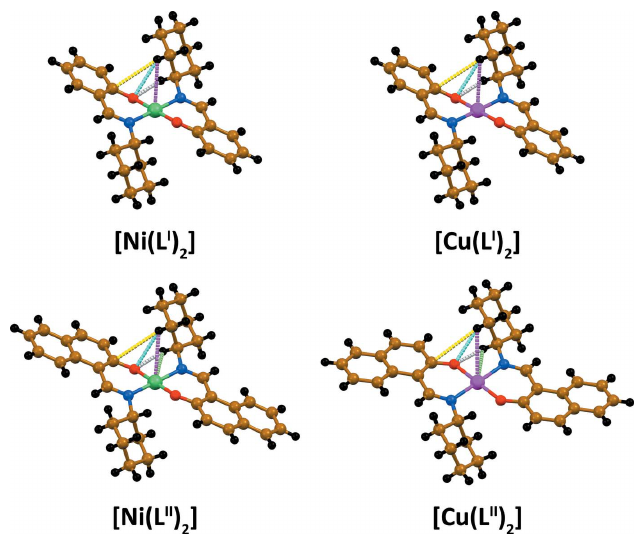
Figure 4 IQA energy decomposition of the selected diatomic interactions obtained at the MP2/6-311 + G(d,p) level of theory for the crystal monomers of [Ni( L I,II ) 2 ] and [Cu( L I,II ) 2 ] (see Table 4 for